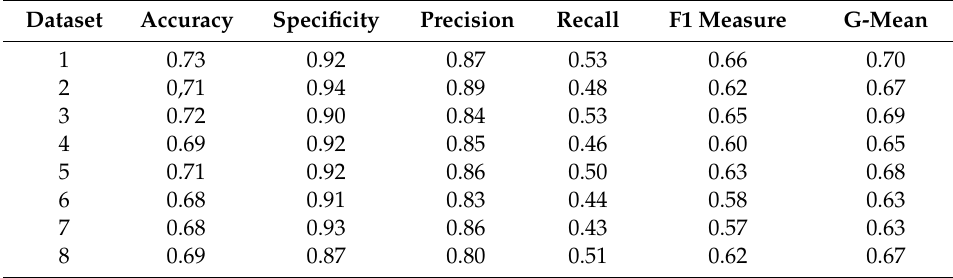
Table 5. Results of